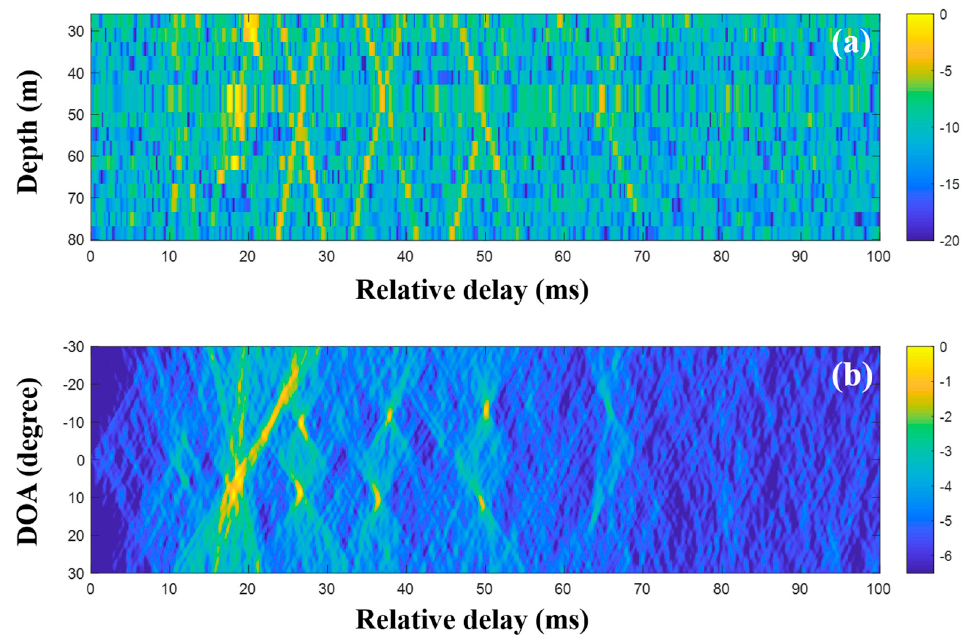
Figure 2. Direction-of-arrival (DOA) estimation using the matched filter (MF) with a single measurement. The signal-to-noise ratio (SNR) is − 9.8 dB: ( a ) arrival structures via application of the MF to the signals at the vertical line array (VLA) and ( b ) DOAs using delay-and-sum beamforming with the arrival structures.